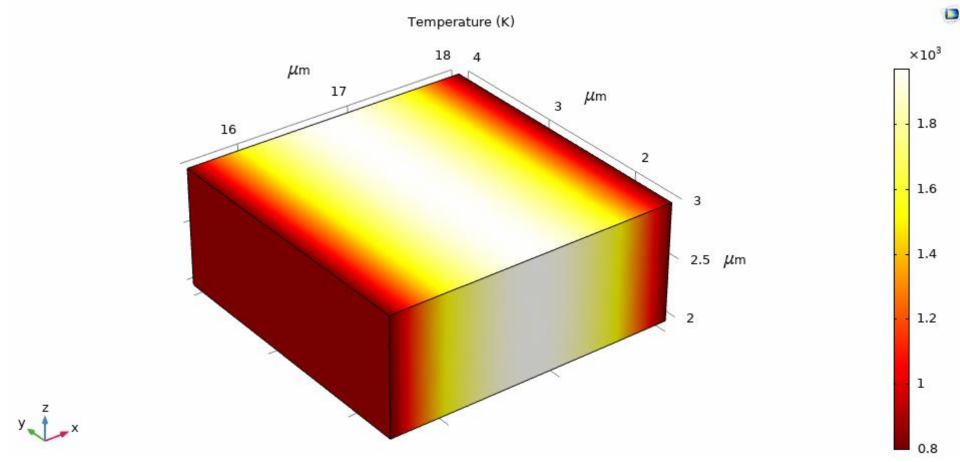
Figure 8. The temperature distribution of the specimen when the electric field intensity is 300 V/cm. It can be explained by Joule heating occurring inside the sample. When current flows through the sample, the sample generates a large amount of Joule heat. Joule heat will generate a lot of heat and cause the temperature to rise, which will further reduce the resistivity of the conductor. When the electric field intensity is constant, according to P = U 2 /R, the thermal effect of electric energy will increase, and the temperature will also increase. It is positive feedback, and thermal runaway of Joule heat will occur, causing the temperature in the sample to increase continuously. Rachman C [37] proposed the densification mechanism of ceramic powder used in the flash sintering process.